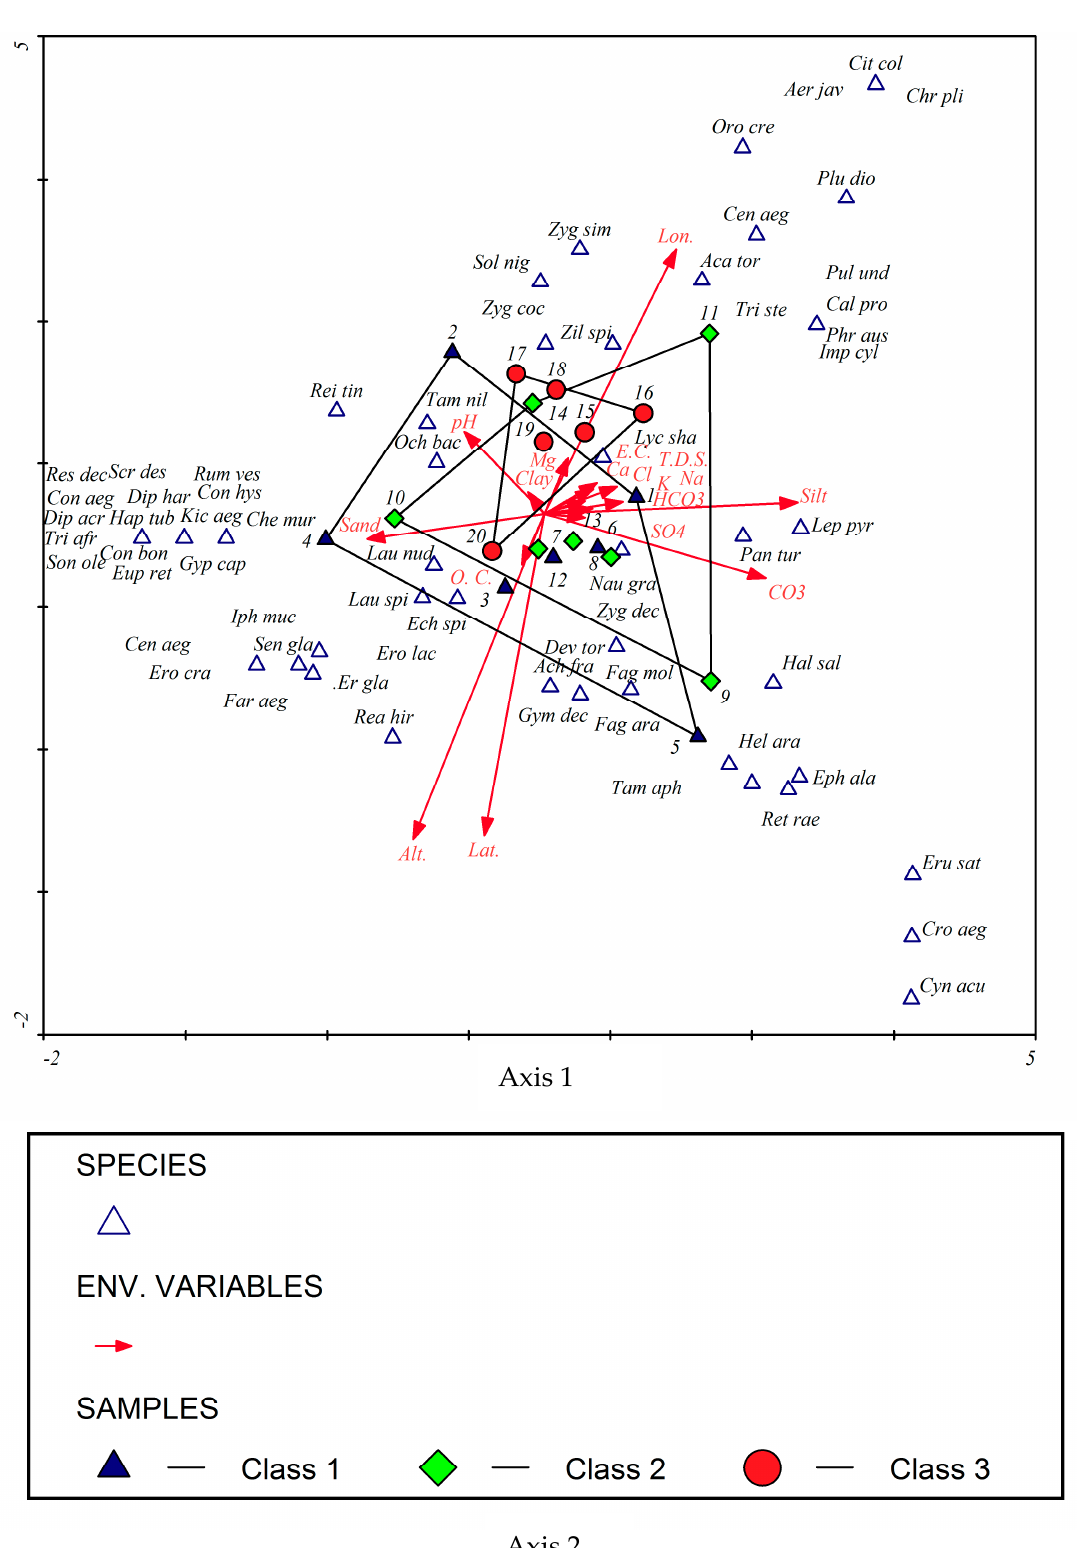
Figure 7. DCCA triplot showing the distribution of the studied localities and the recorded plant species as well as their relationships to environmental factors. The triangles represent species, and the arrows represent environmental variables. Arrow length expresses relative importance of an environmental variable. Dropping perpendicular to the arrows from each of the “species ″ indicates the species ′ relative position along the ecological gradient represented by an arrow.